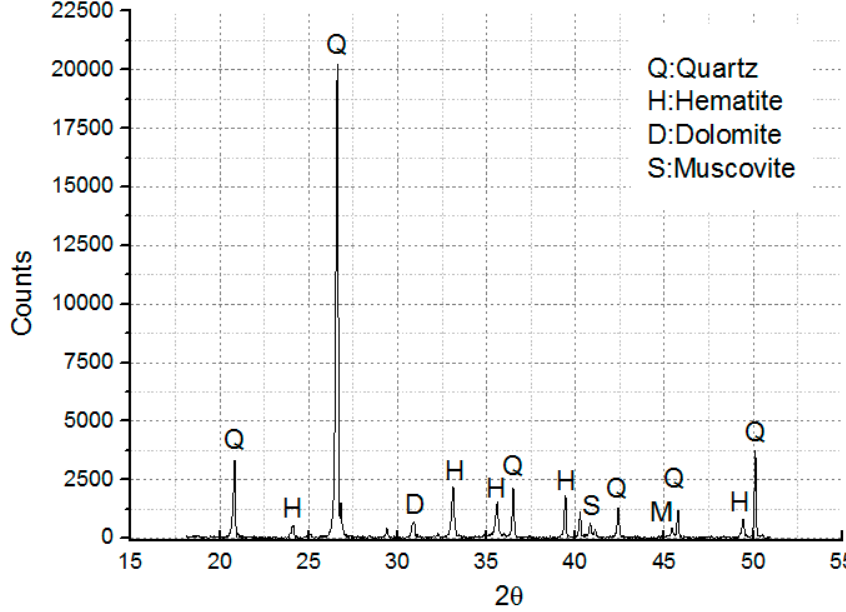
Figure 3. The X-ray diffraction (XRD) profile of the Lilou full tailings.